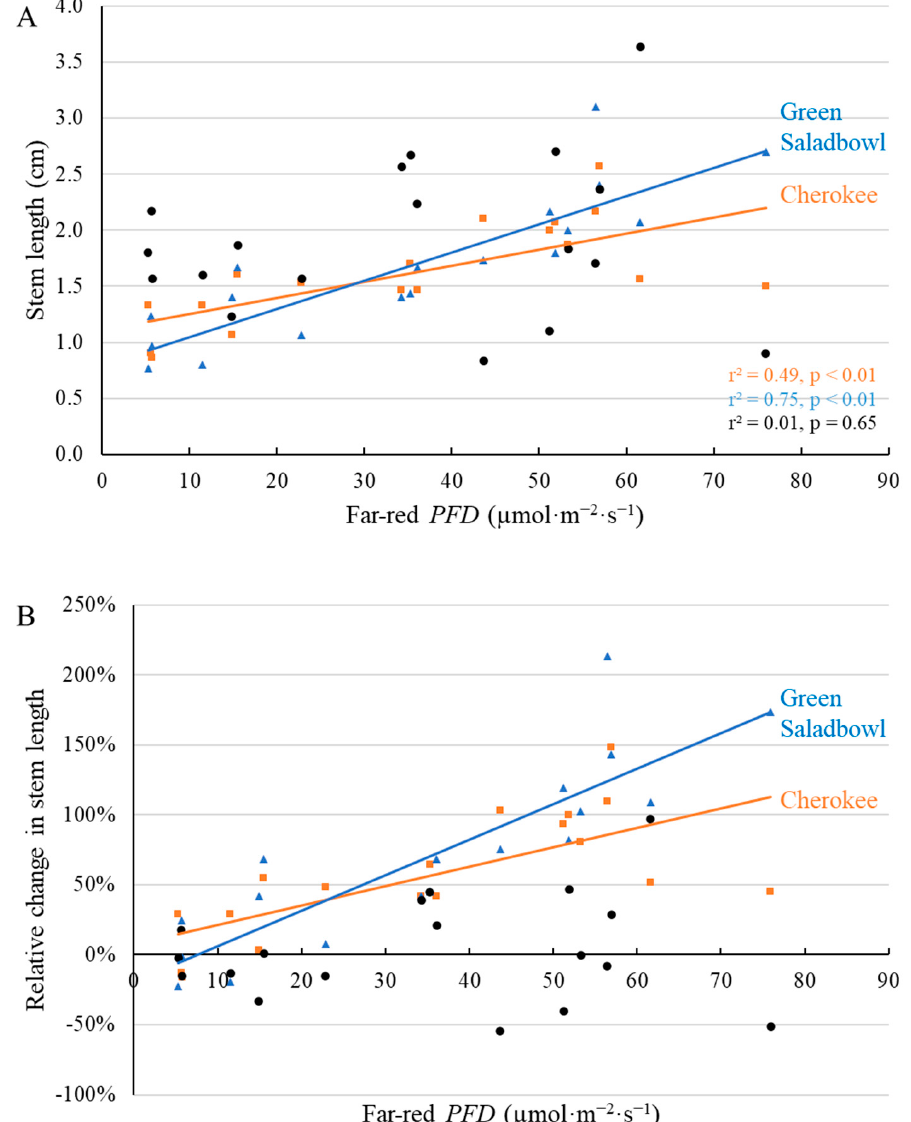
Figure 8. With a background of 204 µ mol · m − 2 · s − 1 white LED light, supplemental far-red photons linearly increased stem length ( A ) and relative stem length (( B ), compared to plants under no supplemental far-red light) 35 days after the start of far-red light treatment for ‘Cherokee’ and ‘Green Saladbowl’, but not for ‘Little Gem’ (black dots) lettuce. The r 2 and p values for regression of each cultivar apply to both graphs and are shown with the respective color.